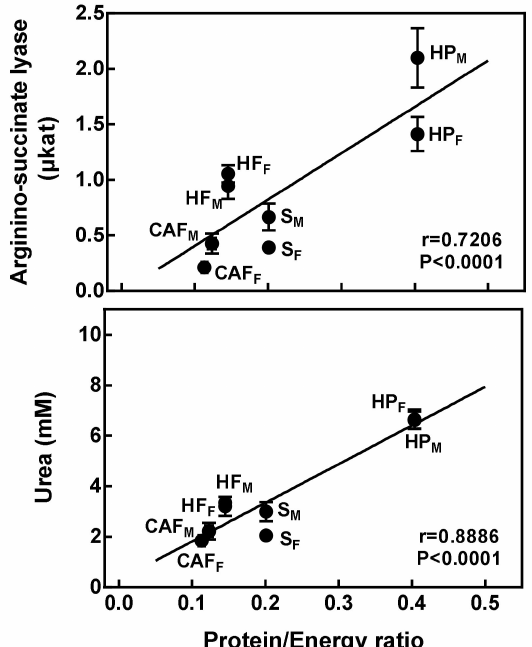
Figure 3. Relationship between the diet protein/energy ratio with total liver arginine-succinate lyase activity and plasma urea levels. The protein/energy ratio refers to the energy ingested derived from proteins versus total energy ingested. Lines of regression, correlations, and p -values were calculated using all individual data ( n = 52). Abbreviations: S is standard diet, CAF is cafeteria diet, HF is high-fat diet, HP is high-protein diet, F means female rats, and M means male